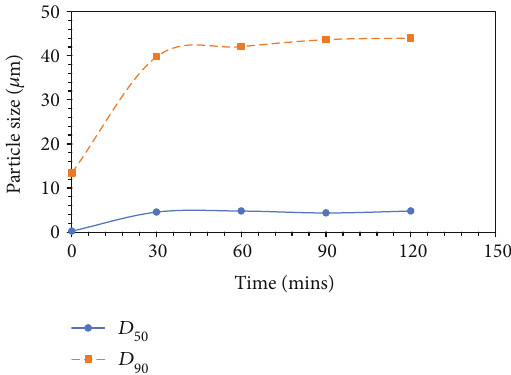
Figure 2: Swelling behavior of bentonite particles with age.